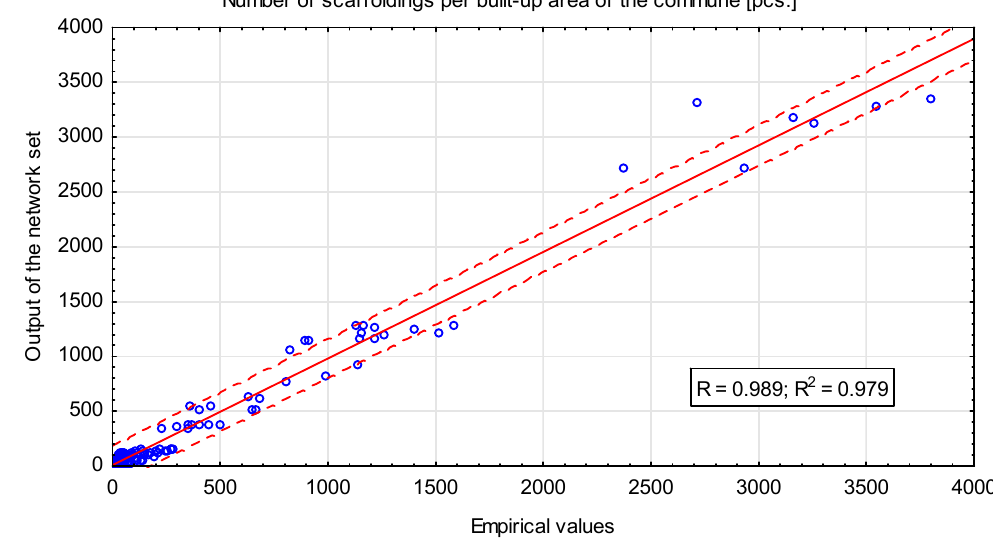
Figure 6. Graph of the quality of matching the output values of the set of networks and the empirical values (in red: the area of the confidence level of 0.95 of the model’s prediction).